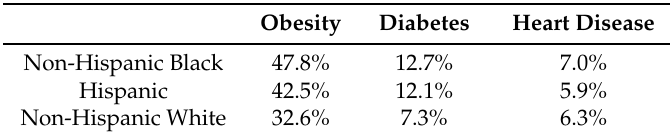
Table 1. Prevalence of chronic disease by ethnicity [6–9].